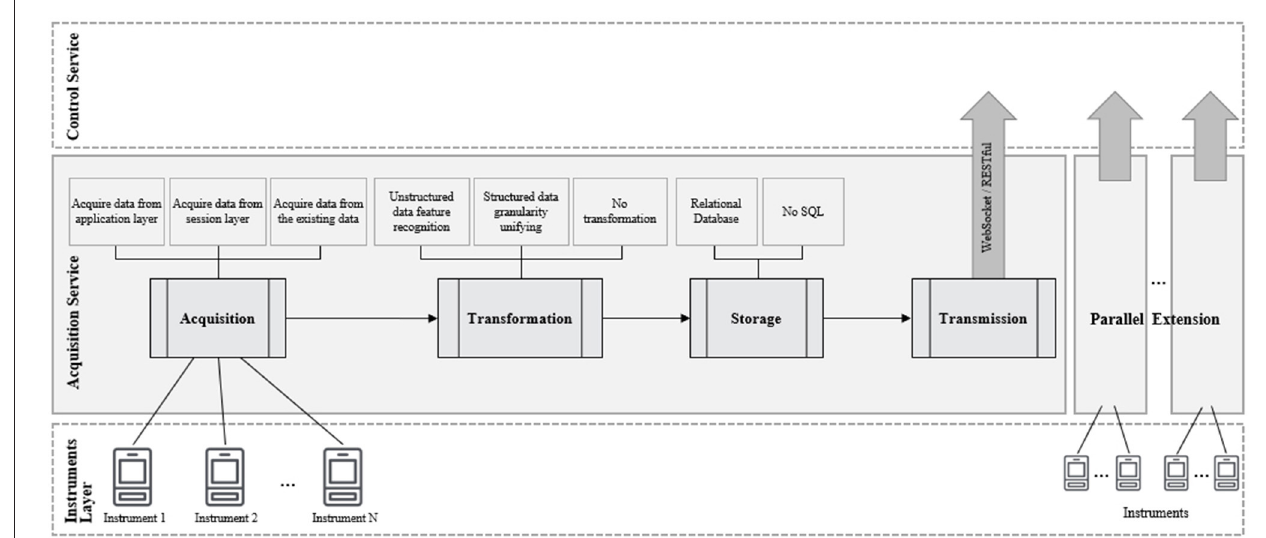
FIGURE 2 | The flow of acquisition